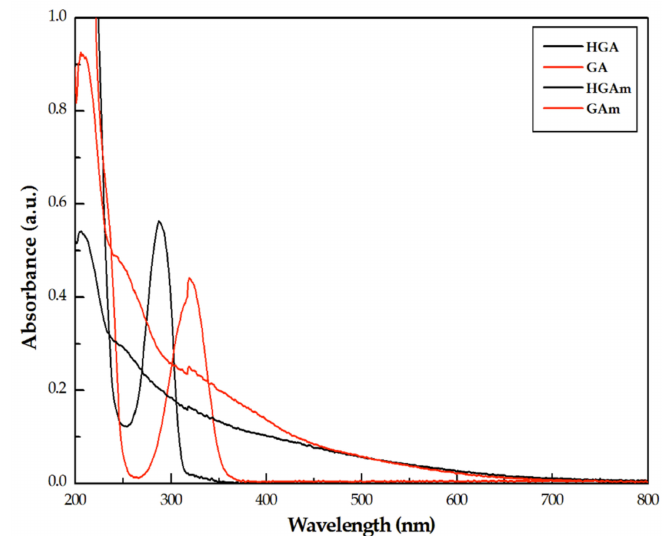
Figure 1. UV–vis spectra of HGAm (black line) and GAm (red line) paired with the corresponding UV–vis spectra of the monomers (HGA, black and GA, red). The measurements were carried out at room temperature (T = 298 K).